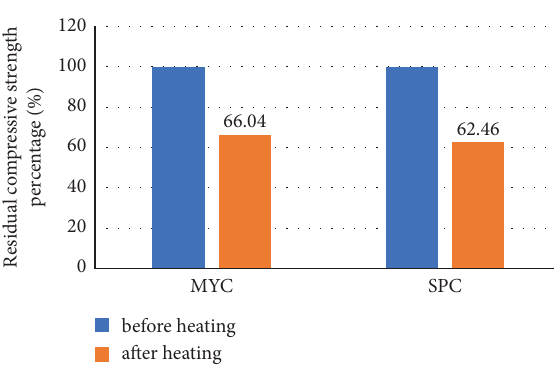
Figure 7: Comparison of residual compressive strengths between MYC and SPC concrete.